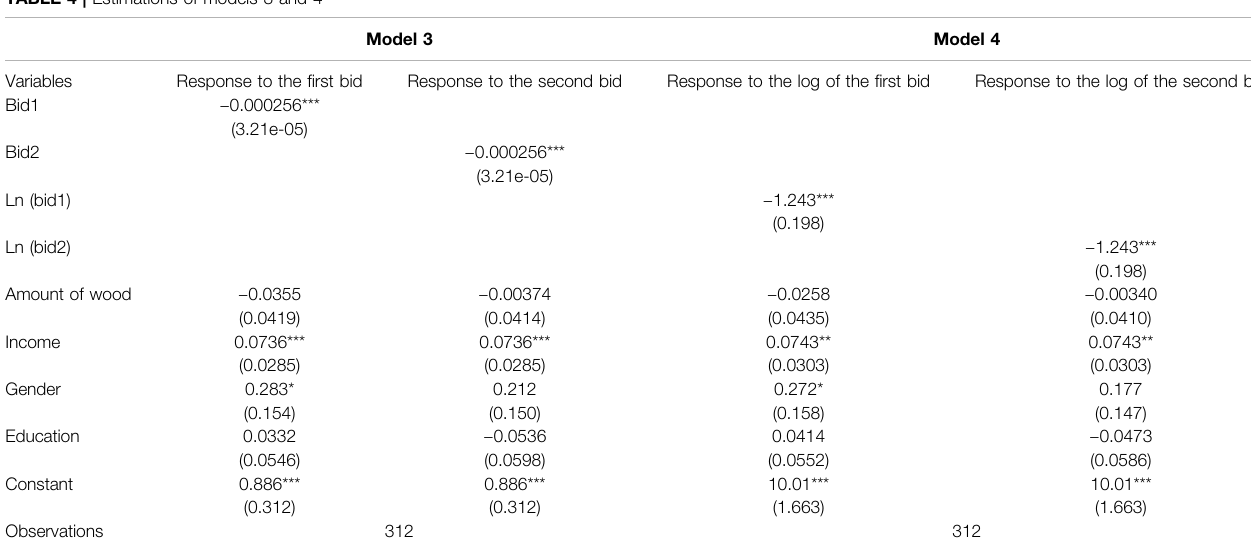
TABLE 4 | Estimations of models 3 and 4